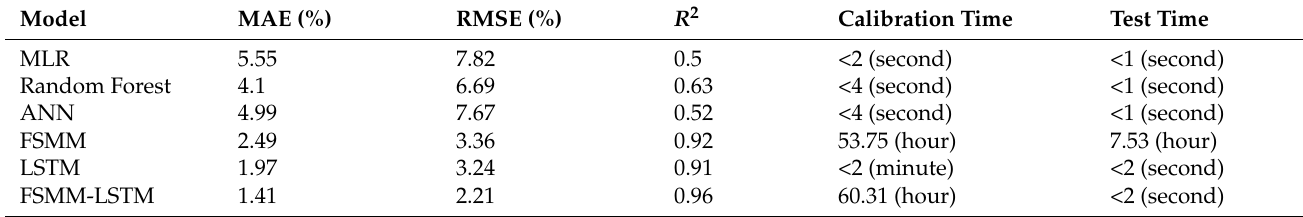
Table 3. the performance and the time cost of each model.